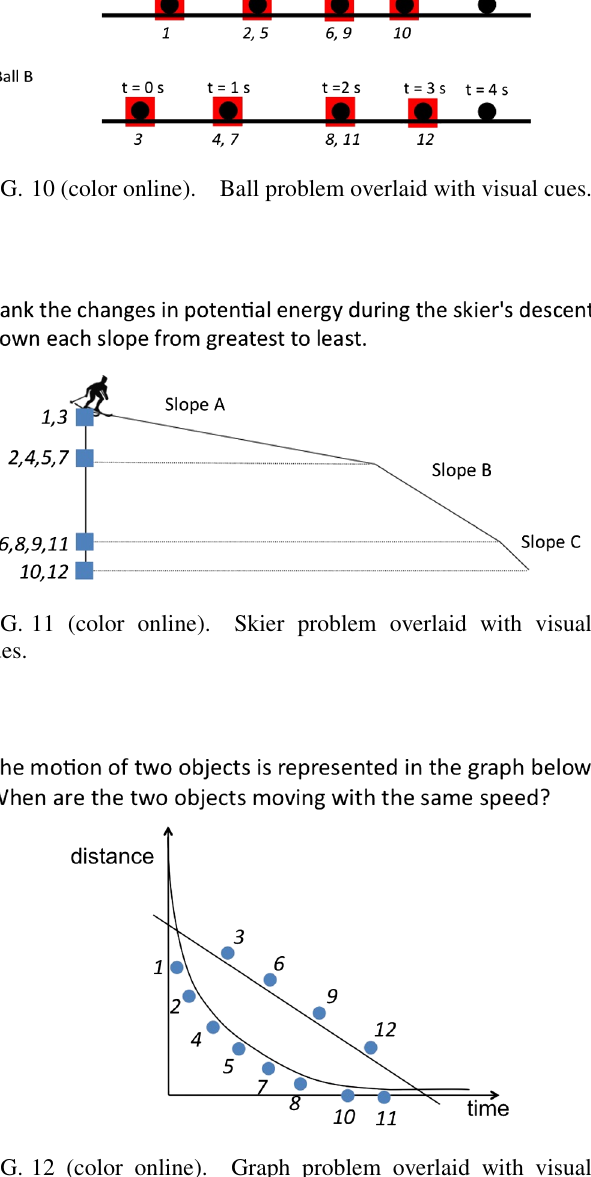
FIG. 12 (color online). Graph problem overlaid with visual